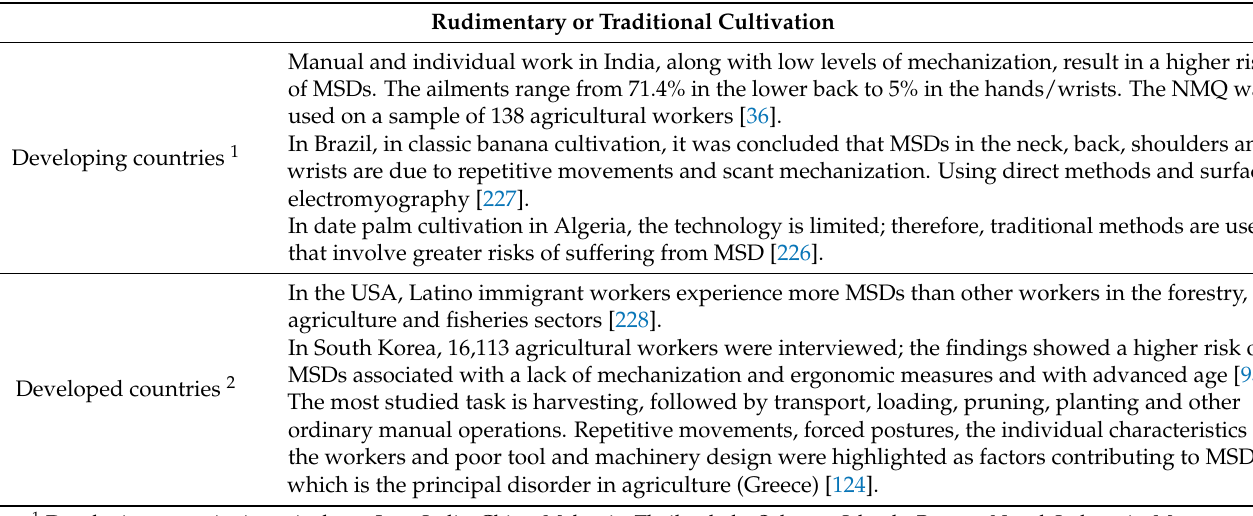
Table A14. MSD research in agriculture (1995–2020). Category: Rudimentary or traditional cultivation. Rudimentary or Traditional Cultivation